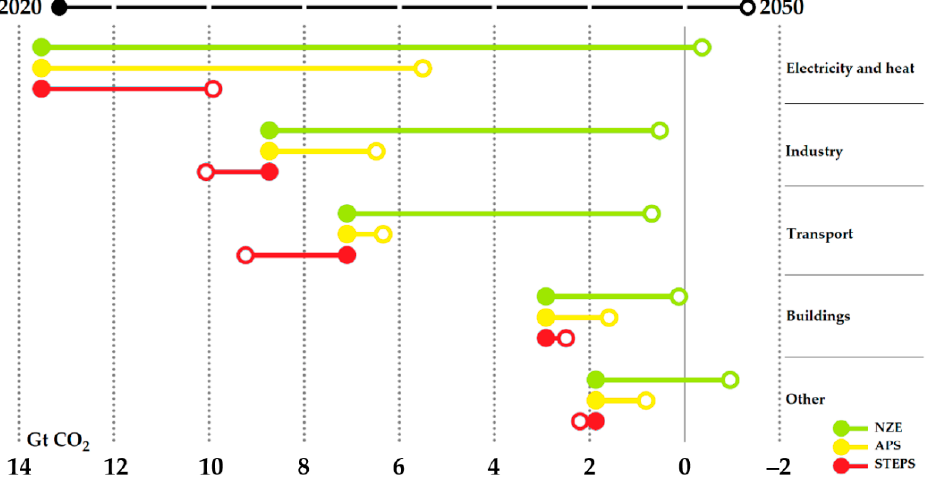
Figure 3. International Energy Agency (IEA) estimate of the evolution of CO 2 emissions between 2020 and 2050 considering three different scenarios. Adopted from [39].